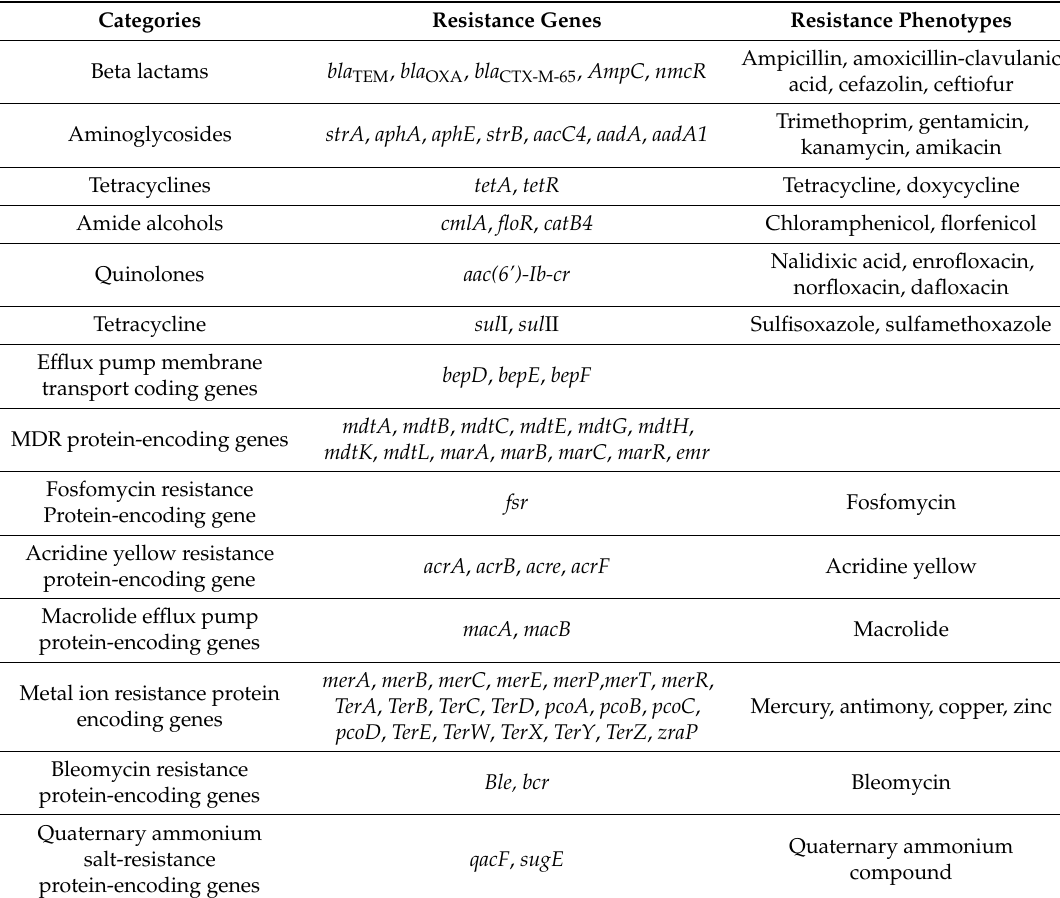
Table 3. Classification of genes detected by PCR and BLAST on the strain MHYL